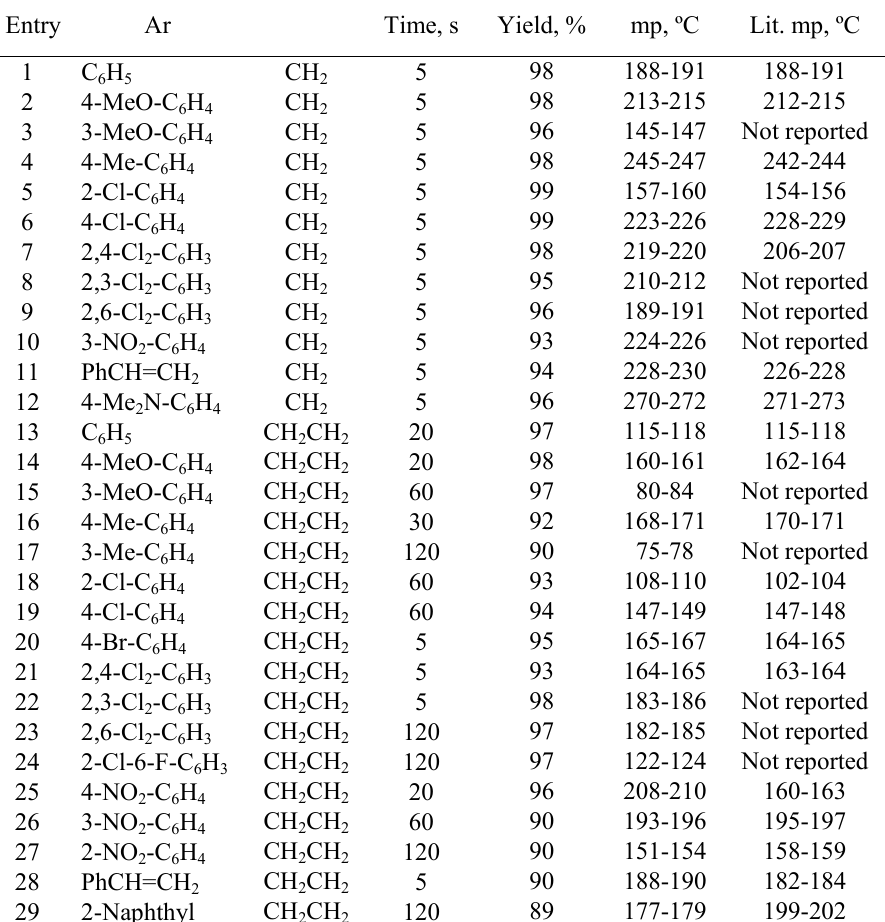
Table 2. Preparation of α , ά -bis(substituted arylidene)cycloalkanones catalyzed by KOH at 40 °C